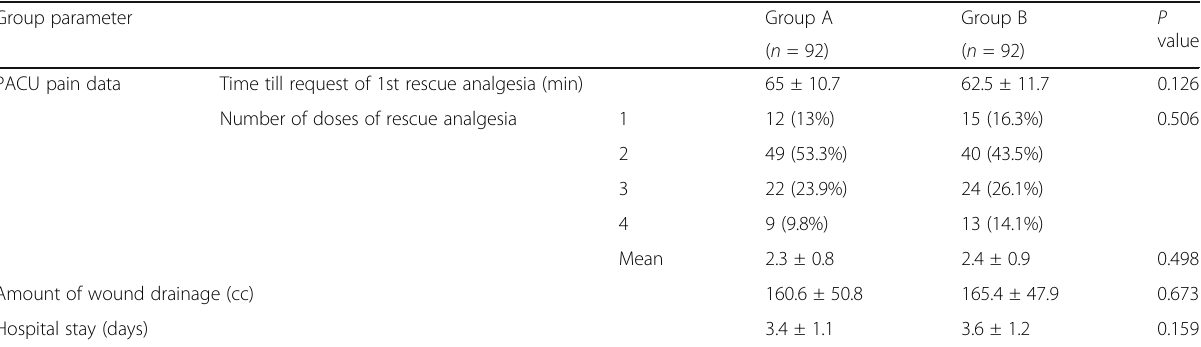
Table 4 Postoperative data of studied patients Group parameter